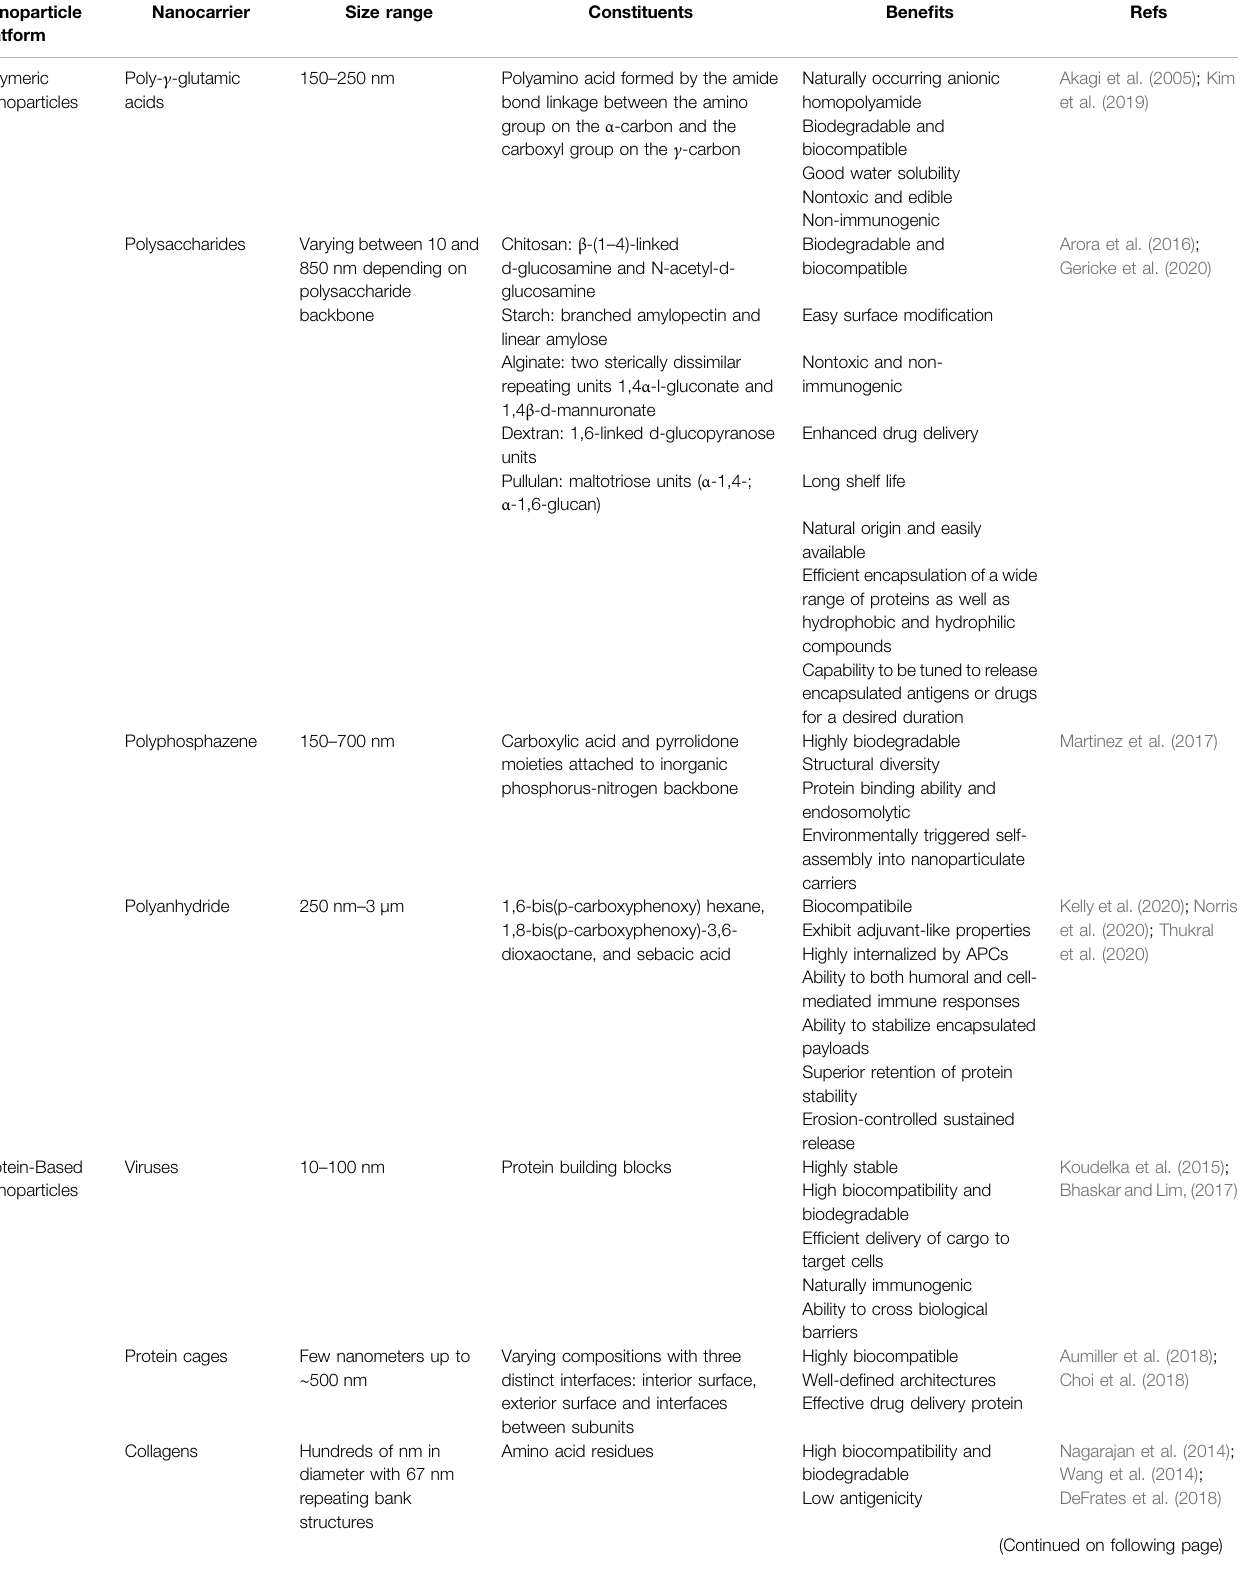
TABLE 1 | Size, constituents and bene fi ts of key